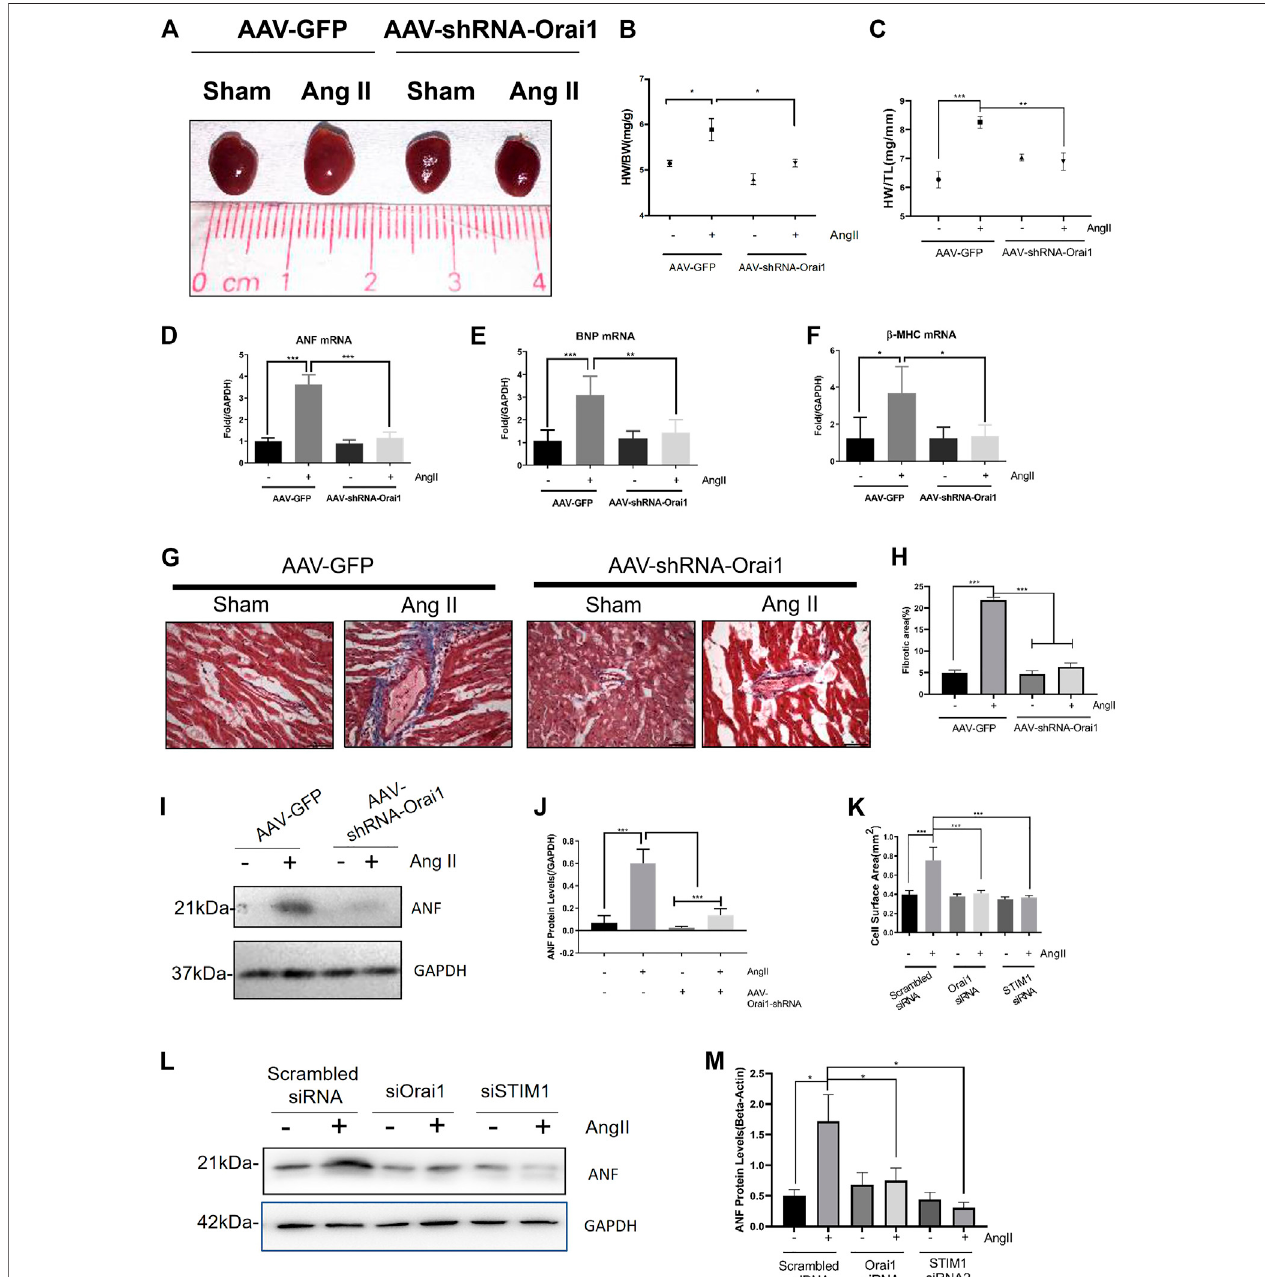
FIGURE 4 | Orai1 knockdown suppresses the Ang II-induced cardiac hypertrophy in vivo . Representative images (A) and data summary of Heart Weight/Body Weight (B) and Heart Weight/Tibia Length (C) revealing the effect of AAV-shRNA-Orai1 in the Ang II treatment group (n (cid:2) 5) and sham group (n (cid:2) 5) are shown (D – F) mRNA levels of hypertrophic markers ANF (D) , BNP (E) , and β -MHC (F) in mice heart. Data are normalized to the vehicle group treated with AAV-GFP (G, H) Representative immunoblots (G) and data summary (H) of Type I collagen fi bers in mice hearts revealing the effect of AAV-shRNA-Orai1 in the Ang II treatment group (n (cid:2) 5) and sham group (n (cid:2) 5) are shown. Representative images showing AAV-shRNA-Orail mediated reduction in type I collagen levels in the hearts of Ang II treated mice (I, J) The immunoblots and data summary of ANF in mice hearts are shown (K – M) Cell surface area of Orai1/STIM1 knockdown (K) on Ang-II induced cardiac hypertrophy and the representative immunoblots (L) and data summary (M) of ANF in NRCM. ns (cid:2) no signi fi cance, * p < 0.05, ** p < 0.01, and *** p < 0.001.